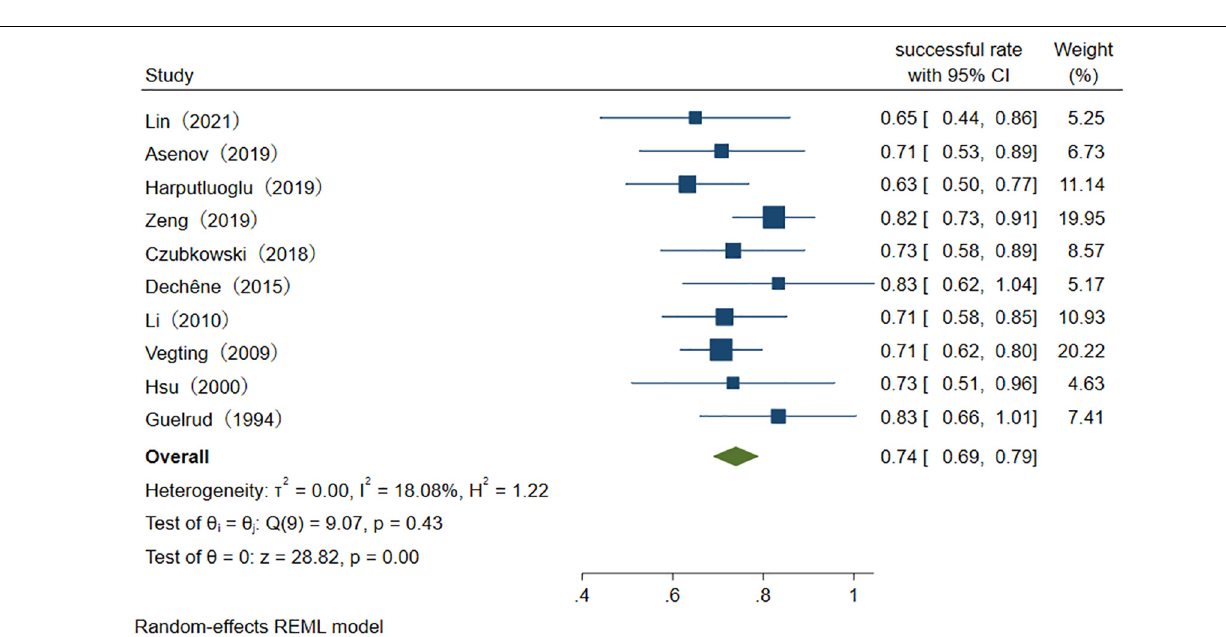
FIGURE 7 | The success rate of therapeutic ERCP procedure.